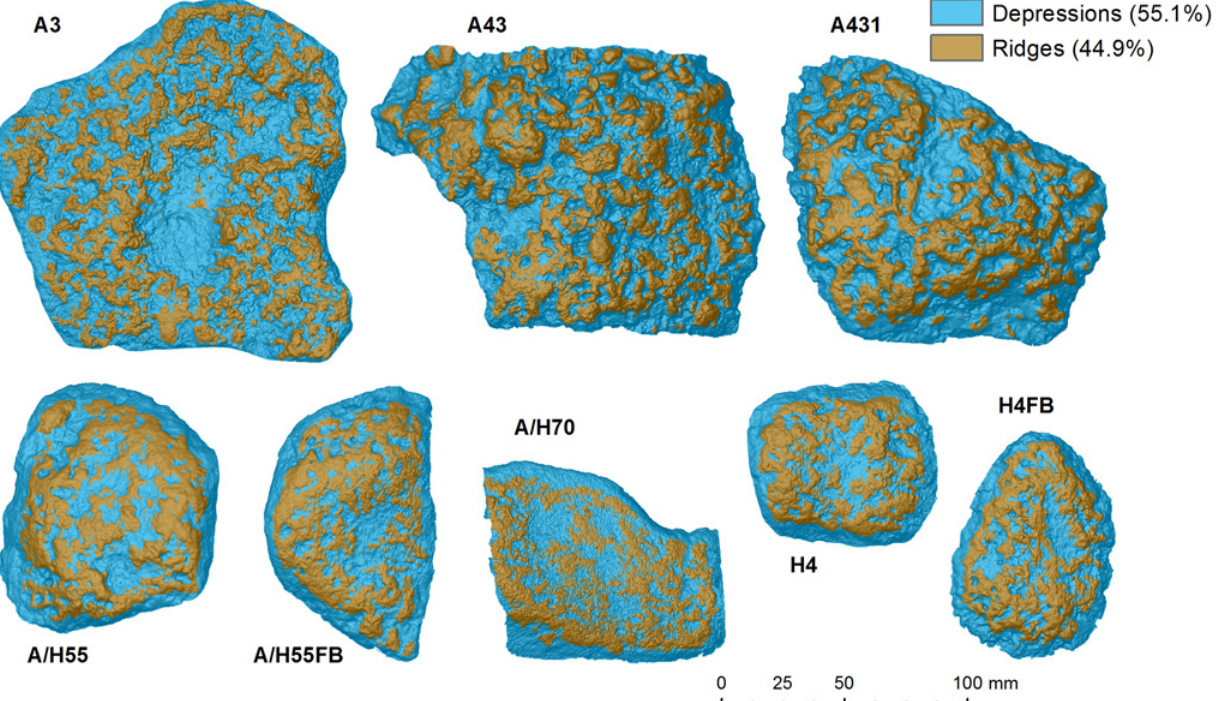
Fig 4. Distribution of depressions and ridges in artifact surfaces, calculated from the classification of models TPI 0.5 mm and TPI 1 mm (S6 Fig.).